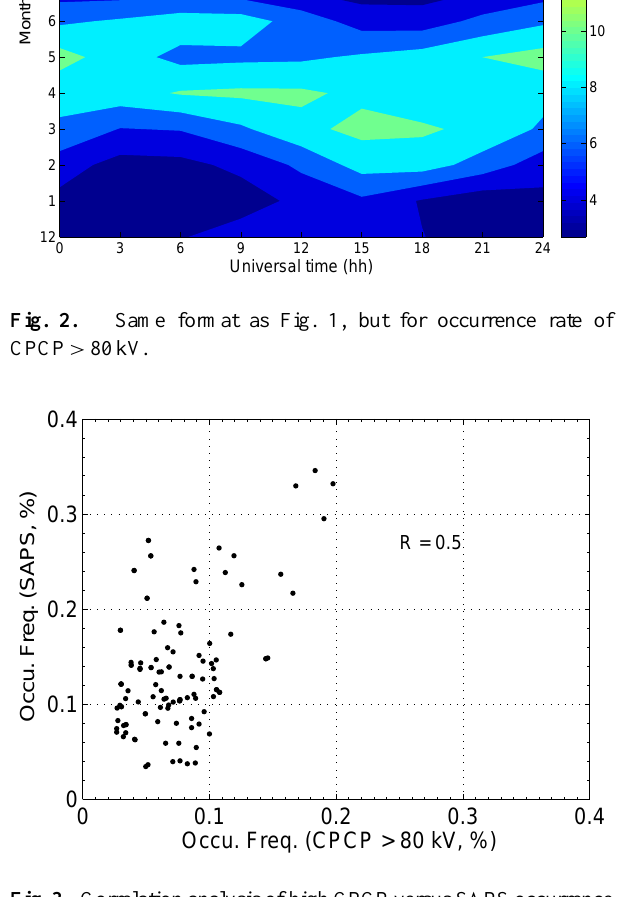
Fig. 3. Correlation analysis of high CPCP versus SAPS occurrence rates.